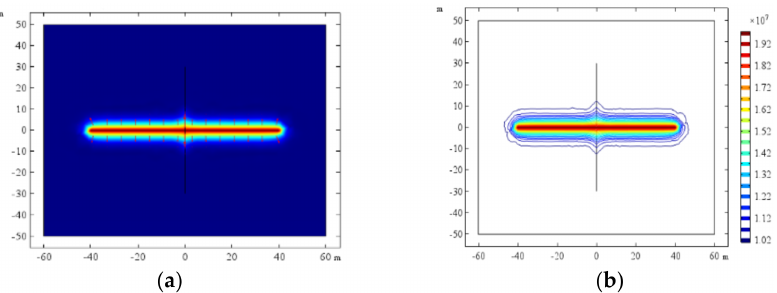
Figure 11. Case 8 calculation result. ( a ) Grout propagation pattern. ( b ) Distribution of grout propagation pressure field.